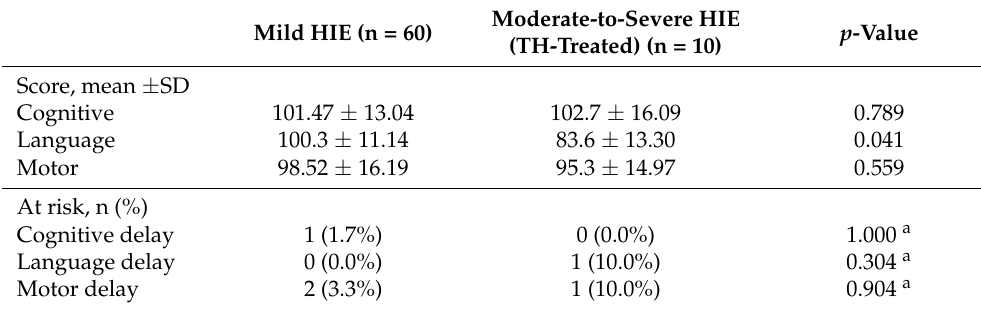
Table 4. Neurodevelopmental outcomes of HIE on Bayley Scales of Infant and Toddler Development III at corrected 18 months (n =